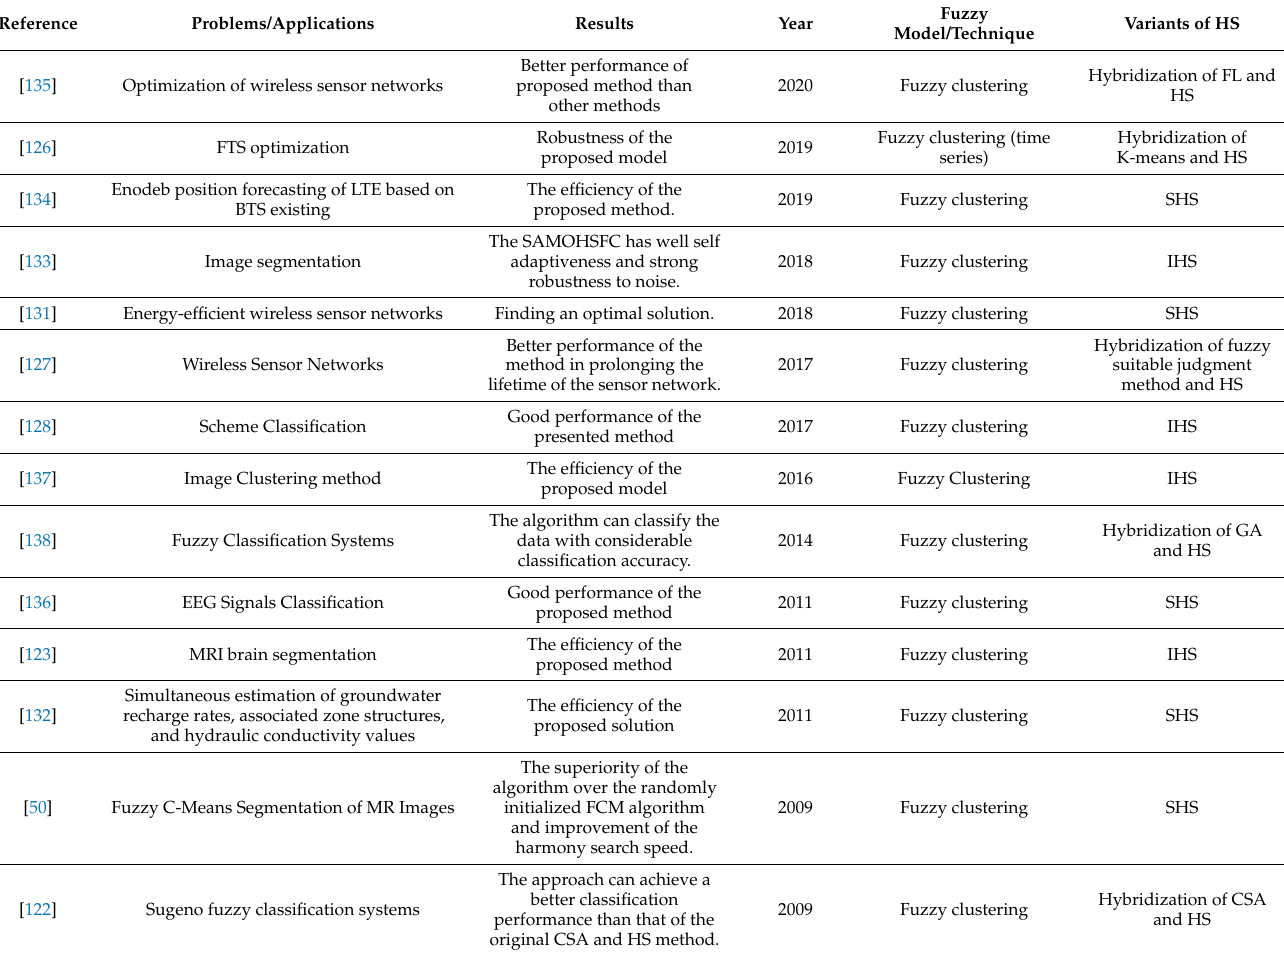
Table 4. A summary of the HS algorithm and fuzzy clustering-based